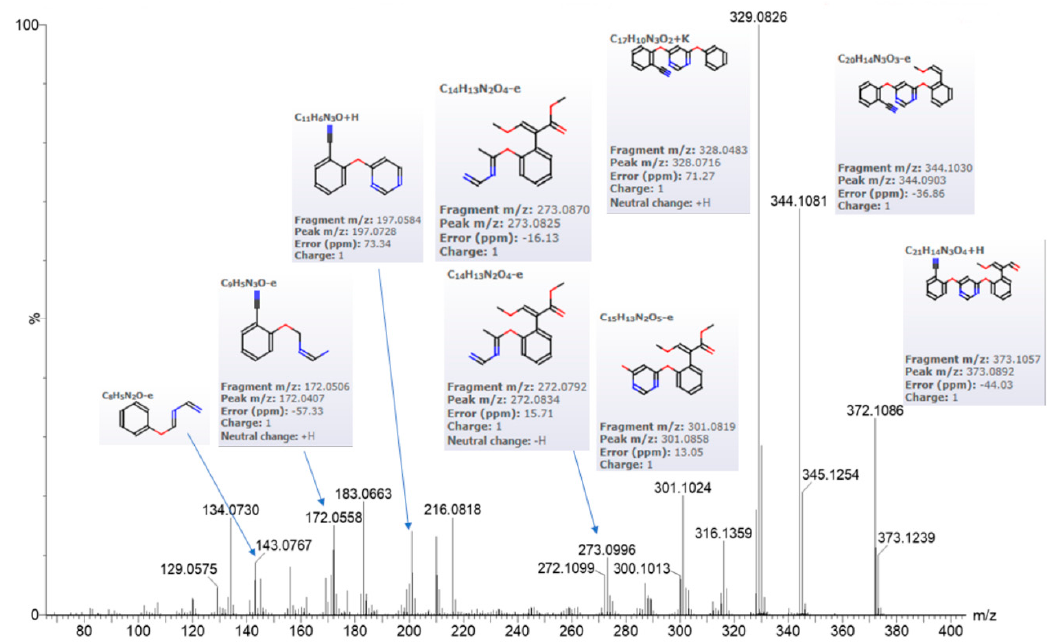
Figure 2. Q-TOF MS / MS DDA profile of the root metabolite extracted from maize root at 28.667 min as retention time. The precursor specie isolated by the quadrupole at 404.09 m / z was subjected to high energy ramping from 10 to 40 eV and its MS / MS profile shown here clearly indicates the presence of fragments of azoxystrobin as assessed by comparing the peak with similar fragmentation pattern from massbank (http: // www.massbank.jp / RecordDisplay.jsp?id = AU324504&dsn = Athens_Univ). The peak annotation has extracted by Progenesis QI Metascope built-in fragmentation and annotation